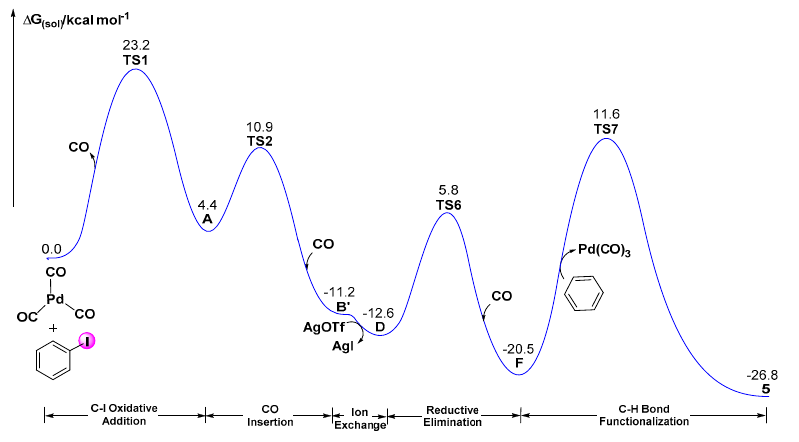
Figure 5. Full reaction potential energy surface of Path III.